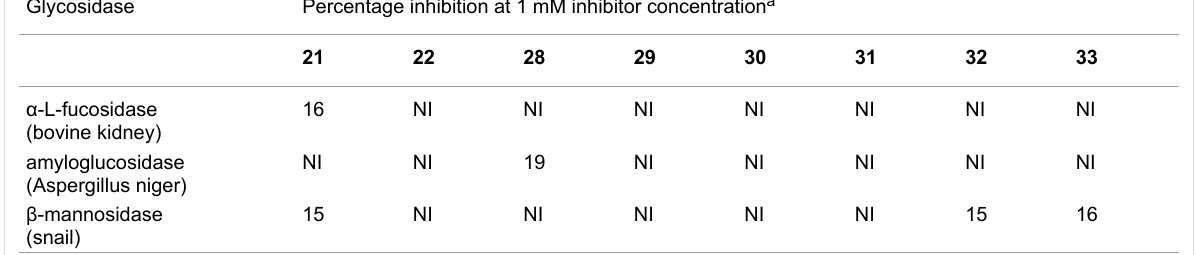
Table 1: Inhibition of activity of commercially available glycosidases.